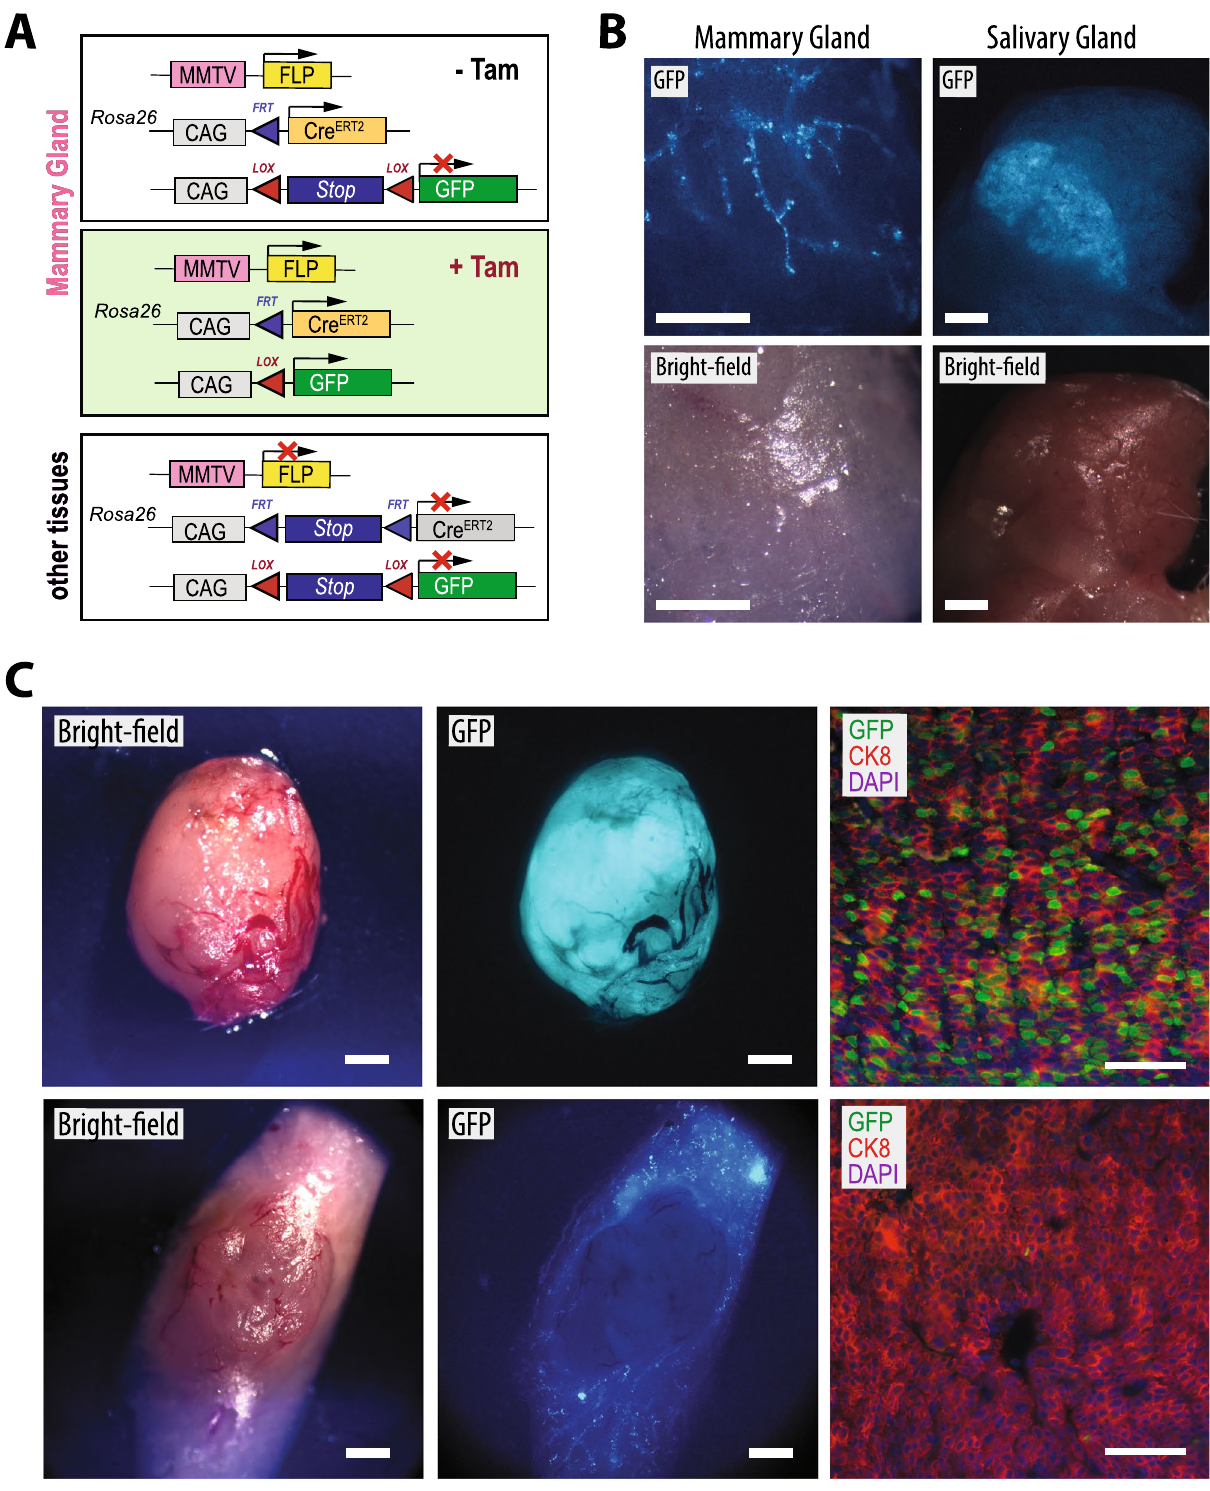
Figure 3. Ligand-inducible Cre recombinase action in an MMTV-Flp-dependent manner in normal and neoplastic mammary epithelial cells in vivo. ( A ) Schematic outline of the conditional expression of GFP from a Cre/ lox P reporter transgene (CAG-LSL-GFP) following the tamoxifen (Tam)-inducible activation of the Cre ERT2 recombinase specifically in epithelial cells that express or that had expressed the MMTV-Flp transgene. ( B ) GFP and bight-field images of a mammary gland and salivary gland of an MMTV-Flp Rosa26 CAG-FSF-CreERT2 CAG-LSL- GFP triple transgenic female; bars, 1 mm. ( C ) Matching bight-field and GFP fluorescent images (left and center) as well as immunofluorescent staining (right) of GFP-positive (upper) and GFP-negative (lower) mammary tumors from MMTV-neu MMTV-Flp Rosa26 CAG-FSF-CreERT2 CAG-LSL-GFP quadruple transgenic females; bars, 1 mm (left, center) and 50 µm